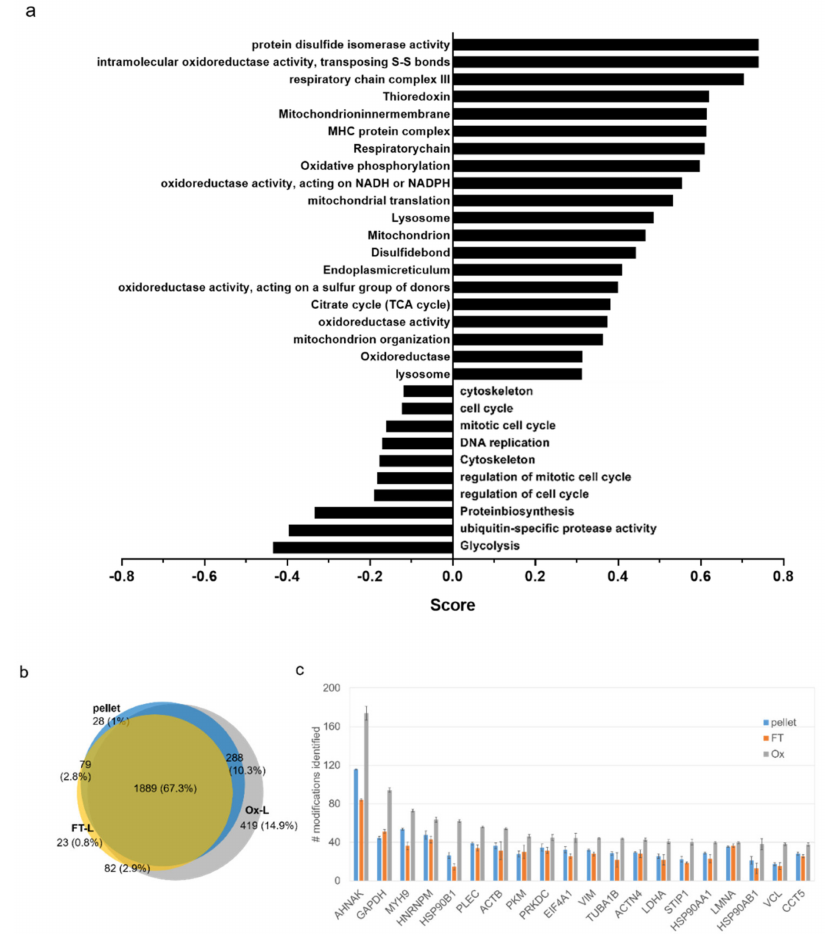
Figure 3. HOCl induces specific patterns of protein oxidation and expression in melanoma cancer cells. ( a ) Significant fold change trends in Ox-L compared to FT-L, obtained from gene ontology enrichment analysis ( p < 0.05). ( b ) Venn diagram reporting the number of oxidized proteins that overlap between pellet (blue circle), Ox-L (grey circle) and FT-L (orange circle) conditions. ( c ) Average number of oxidized residues in the indicated proteins and conditions ± standard deviation ( n = 4 technical